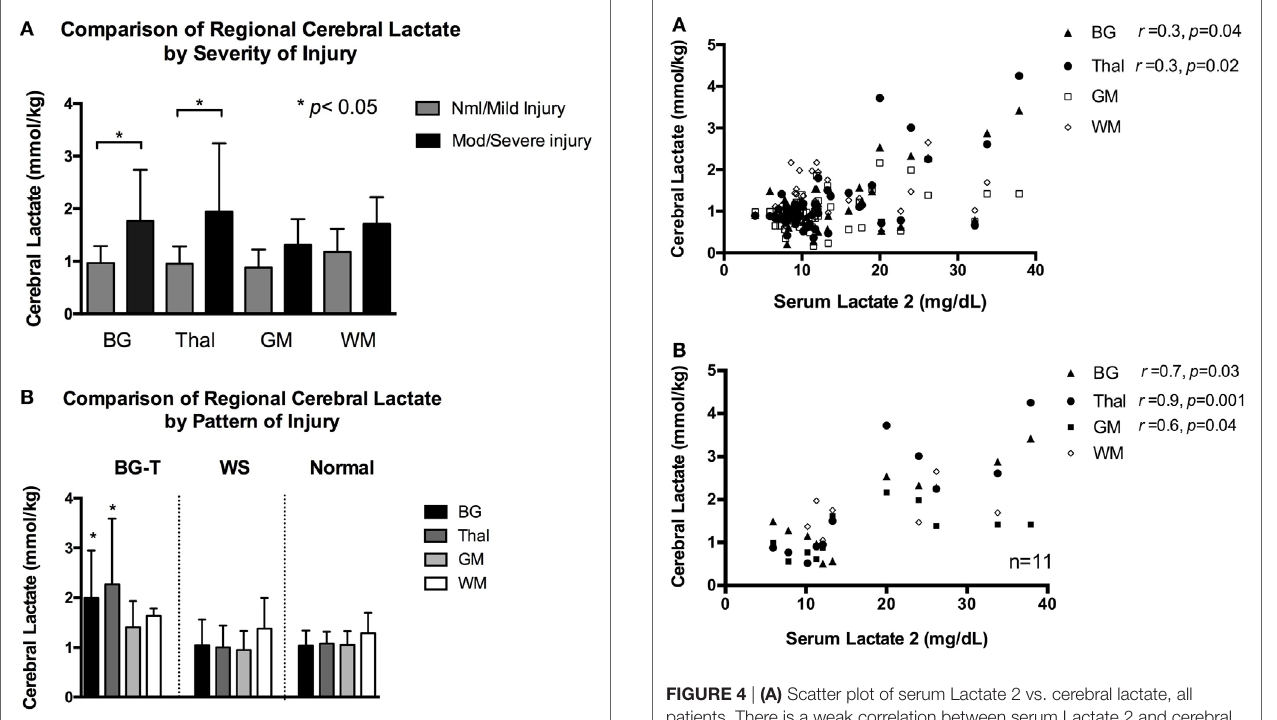
FigUre 3 | (a) Mean regional cerebral lactate concentration during hypothermia in relation to severity of injury. Compared to infants with normal/ mild injury, infants with moderate/severe had significantly higher cerebral lactate concentration at the basal ganglia (BG) and thalamus (Thal) regions (denoted by * p < 0.001). There was no significant difference in regional cerebral lactate concentration among the normal/mild injury group. There was also no significant difference in regional cerebral lactate concentration among the moderate/severe injury group. Gray color bars represent normal/mild injury and black bars represent moderate/severe injury. Error bars represent SD. (B) Mean regional cerebral lactate concentration during hypothermia in relation to pattern of injury. Infants with predominantly BG-Thal pattern of brain injury had significantly higher cerebral lactate concentration at regions BG and Thal (denoted by * p < 0.05), compared to infants with watershed or normal pattern of injury. Black bars represent cerebral lactate concentration measured at BG. Dark gray bars represent Thal. Light gray bars represent gray matter (GM). White bars represent white matter (WM). Error bars represent